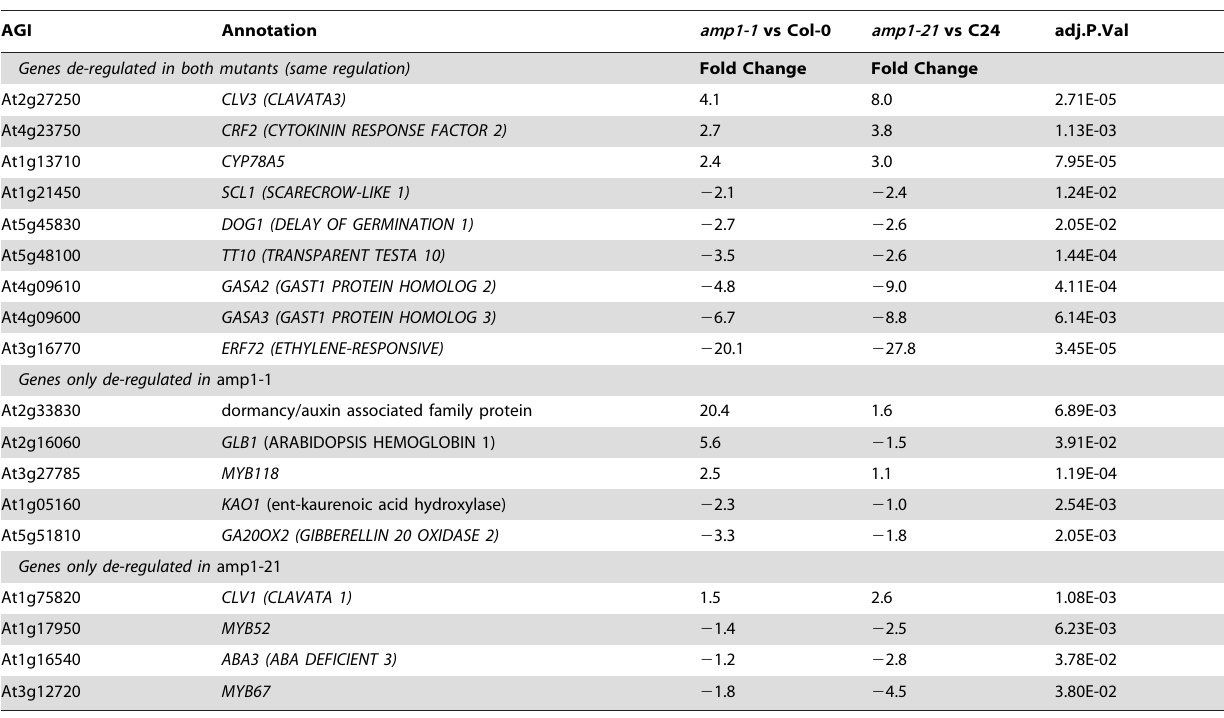
Table 1. Selected genes from the microarray analysis.